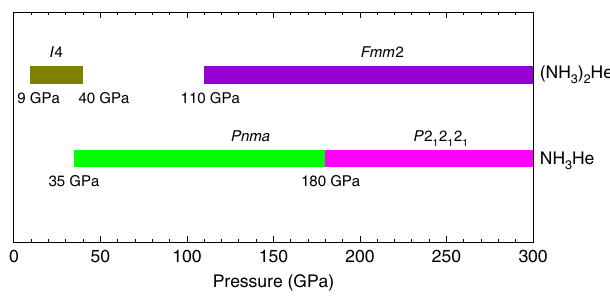
Fig. 2 Pressure-composition phase diagram. Phase diagram showing stable NH 3 − He compounds with respect to pressure at 0 K. Colored regions represent the stable pressure ranges of each composition with respect to a mixture of NH 3 and He. Yellow-green, violet, green and pink represent I 4 – (NH 3 ) 2 He, Fmm 2 – (NH 3 ) 2 He, Pnma – NH 3 He and P 2 – NH 1 2 1 2 1 3 He phase,